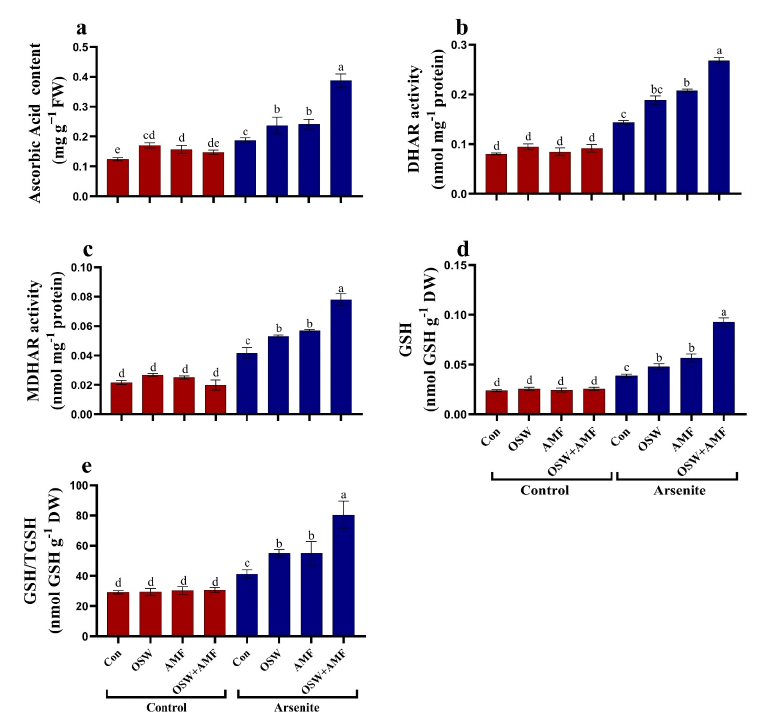
Figure 5. The influence of olive solid waste (OSW) and arbuscular mycorrhizal fungi (AMF), com- bination (OSW+AMF) on ascorbic acid ( a ), DHAR ( b ), MDHAR ( c ), GSH ( d ), and GSH/TGSH ( e ) in wheat plants growing under As III stress. Fishers test at p < 0.05 reveals significant variations in means (± standard deviation), which are different letters on the same bars.